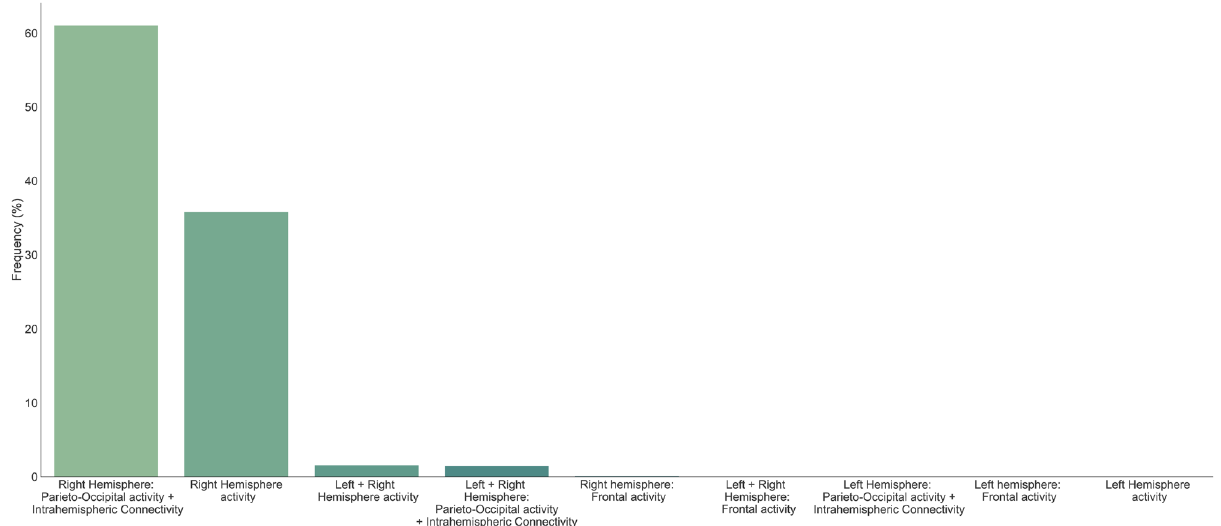
Figure 5. Ranking of feature selection. The relative frequency (%) with which each feature combination was selected across all outer CV folds in 1000 repetitions is shown. The feature combinations have been reordered on the occurring